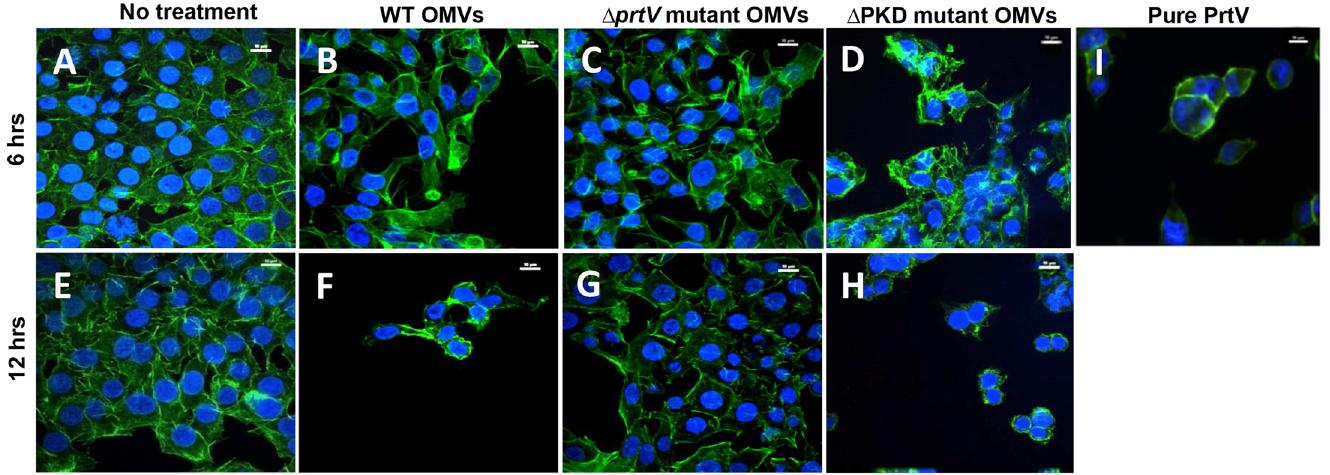
Fig 7. Analyses of biological activities of PrtV. HCT8 cells were treated with 50 μ l OMVs (total protein concentration 60 μ g/ml) from the wild type V . cholerae strain C6706 and the prtV mutant. Cells were treated with 20 mM Tris-HCl as a negative control (A, E), with OMVs from the wild type strain C6706 (B and F) or from the prtV mutant (C and G) or from the the prtV mutant/p Δ PKD PrtV (D and H) or with 20 nM purified PrtV protein for 6 h as a positive control (I). The treatment was performed for 6 h (A, B, C, D) and for 12 h (E, F, G, H). Bars represent 10 μ m.